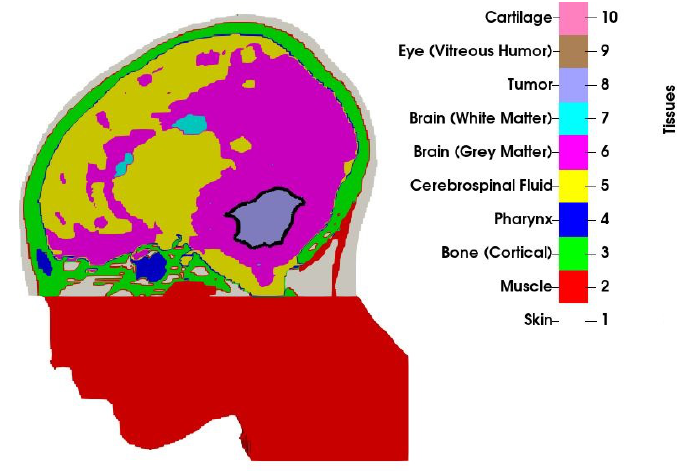
Figure 1. Cross-section of the patient model along with the tissue indices. Border of the tumour is shown with the solid black line.